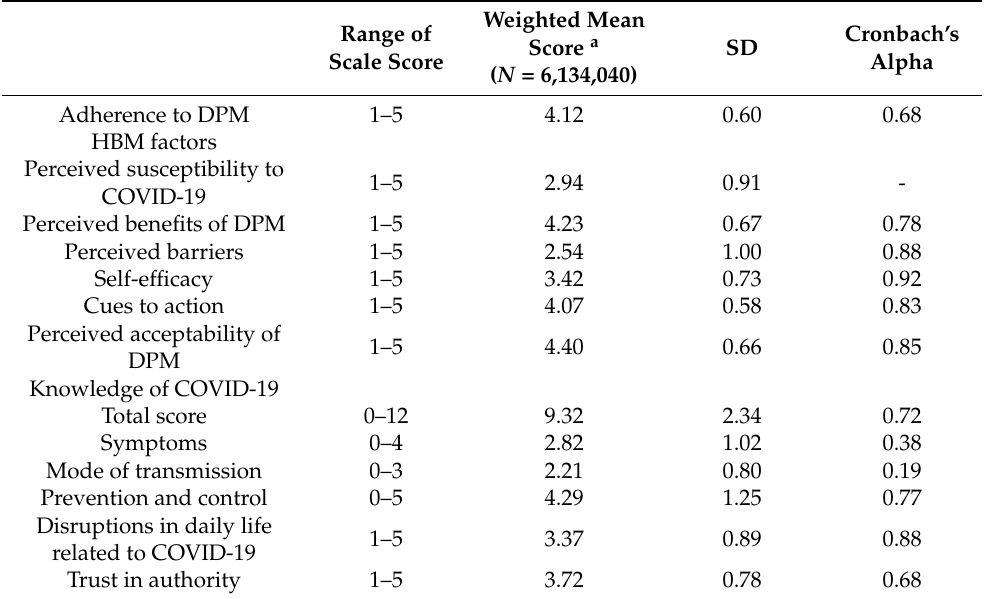
Table 3. Weighted mean scores, SD, and Cronbach’s alpha of the adherence to DPM, HBM factors, awareness of COVID-19, knowledge, perceived disruptions in daily life, and trust in authority.